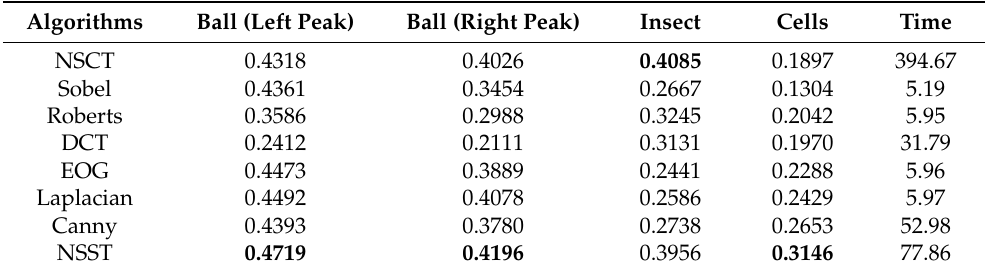
Table 2. Comparison of images’ narrow widths of noise-free public dataset in different algorithms, where ball (left peak) represents the peak on the left and ball (right peak) represents the peak on the right. The maximum value is given in